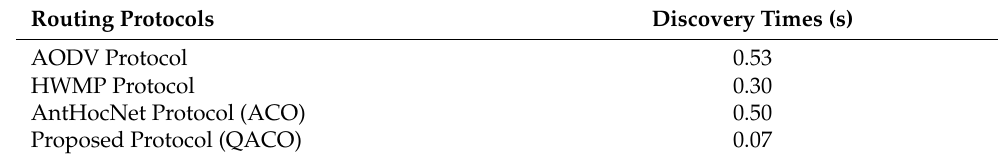
Table 5. Time of new node to discover all